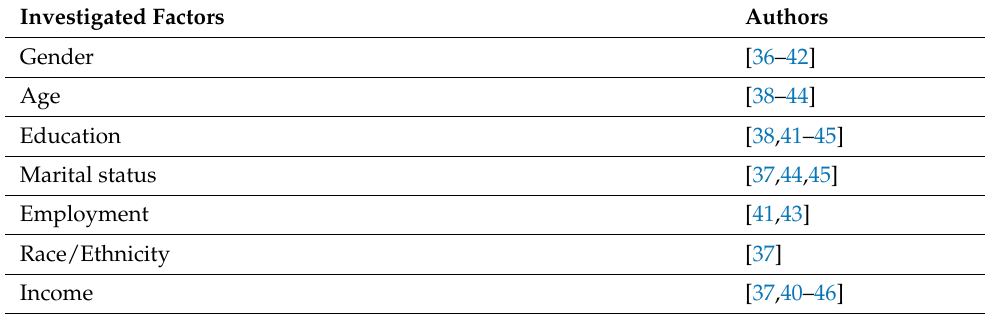
Table 1. Review of factors affecting micro-mobility within the scientific